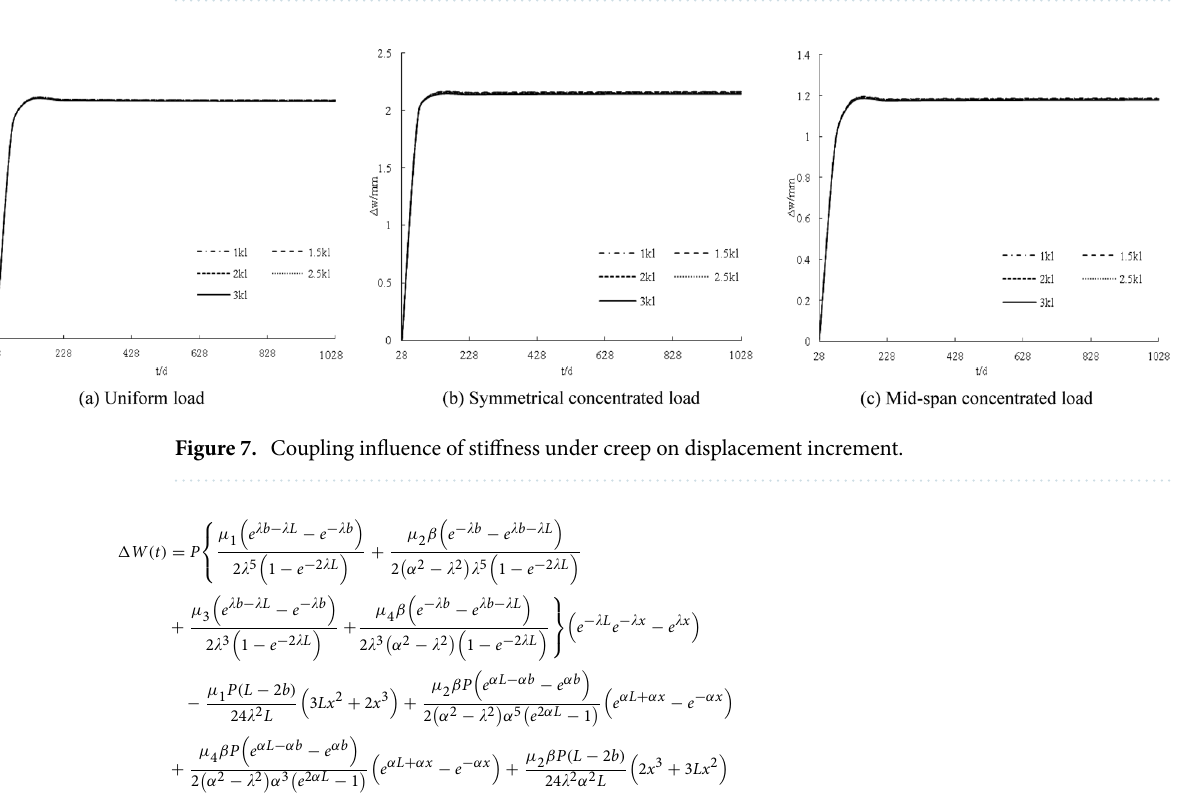
Figure 6. Influence of loading under creep on displacement increment.